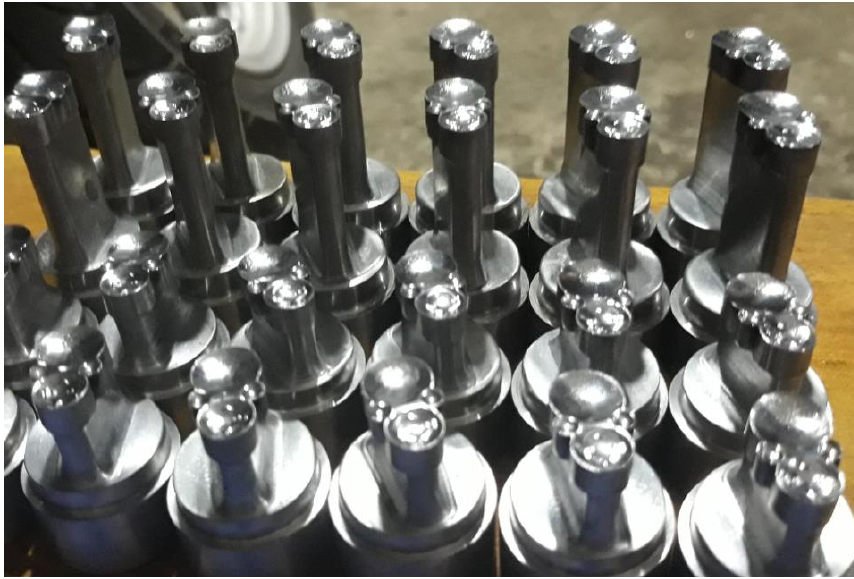
Figure 1. Tablet-shaped punches made by the EDM process.